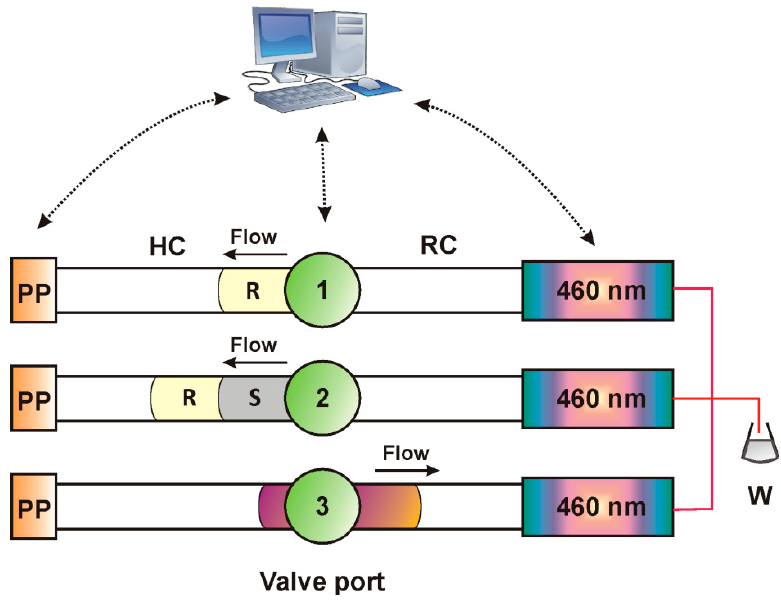
Figure 3. Graphical depiction of the zone fluidics analytical sequence steps for the determination of hydrazine; PP = peristaltic pump, HC = holding coil, S = sample, R = p -DAB / SDS reagent, RC = reaction coil, W = waste.